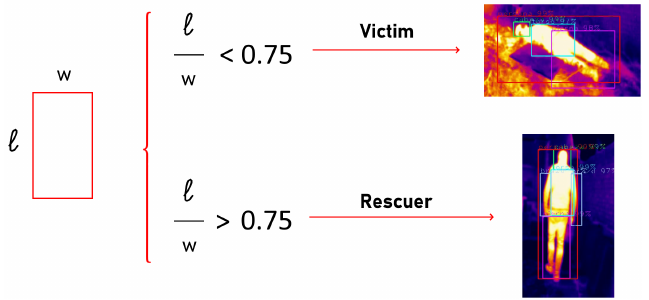
Figure 7. Length-to-width ratio to detect victims. Source: